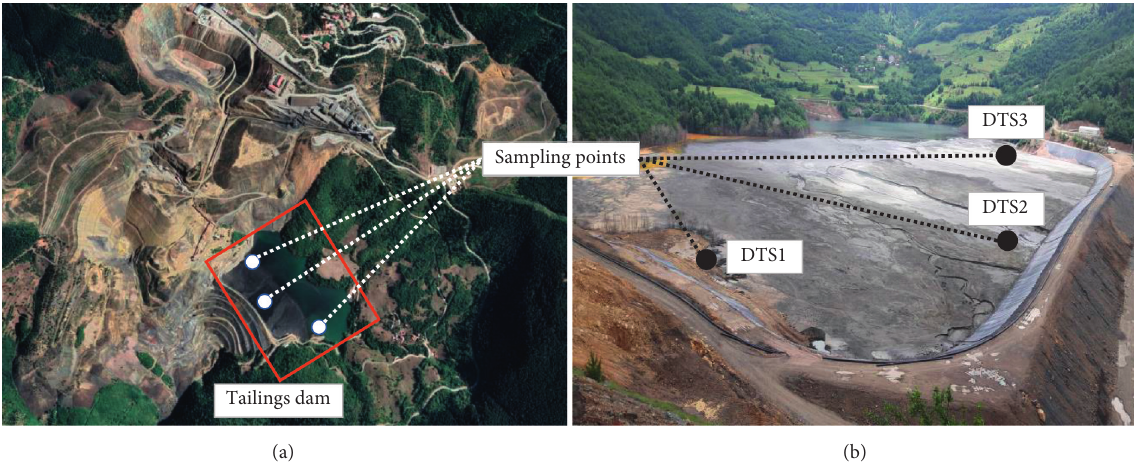
Figure 1: The sample collection points in the tailings dam: (a) satellite view and (b) dam view. Table 1: Tailings’ physical properties.